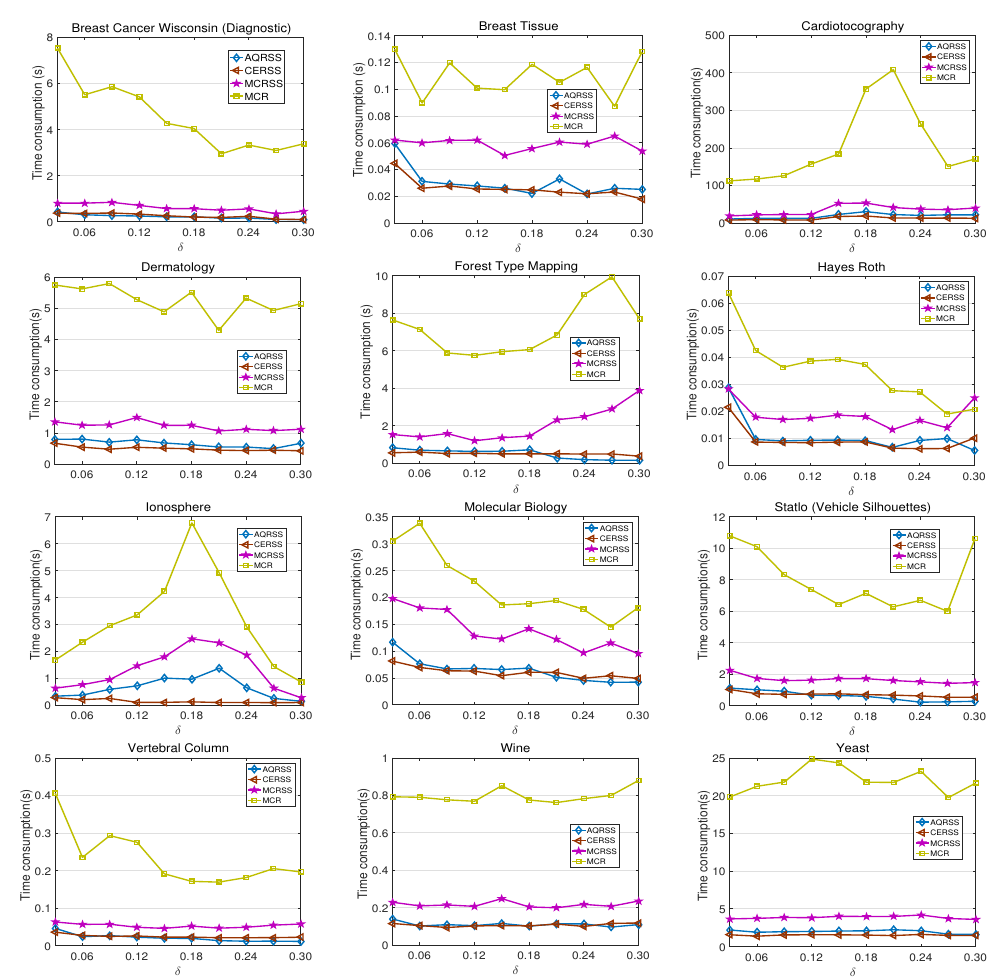
Figure 5. Comparisons of time